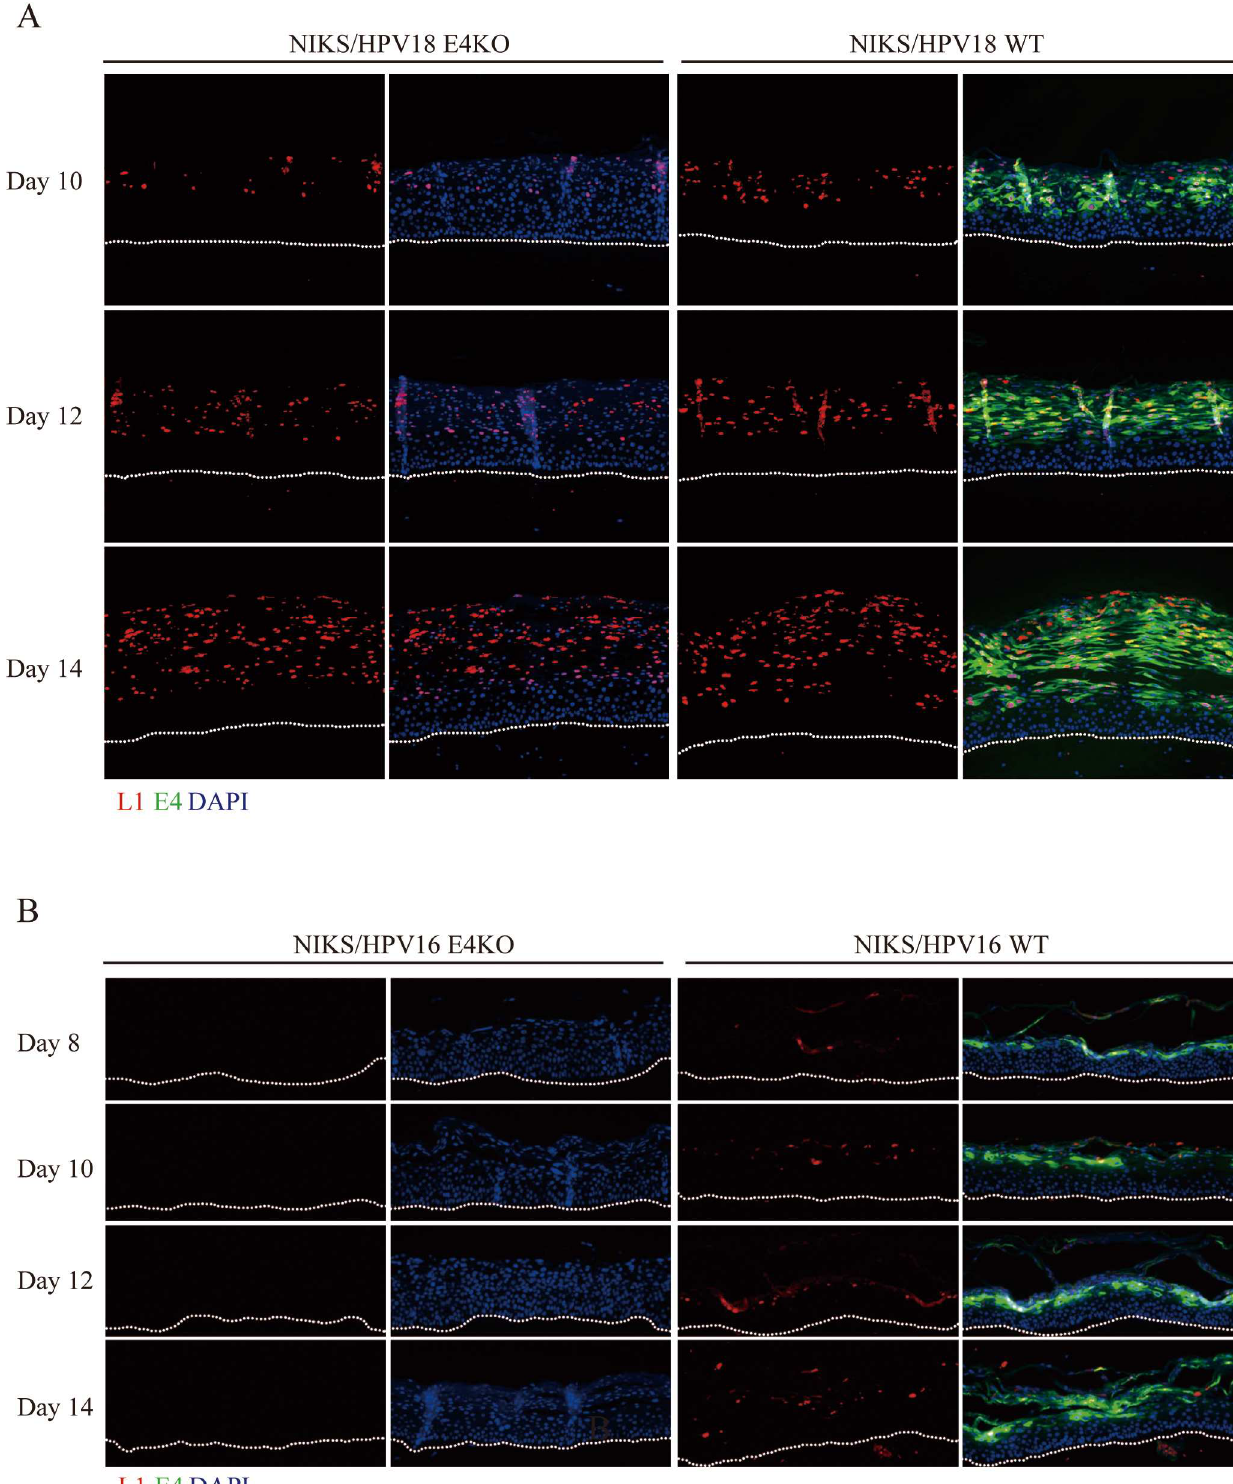
Fig 3. Viral capsid protein expression appears linked to viral genome amplification success in HPV16 and 18 rafts. Raft sections derived from NIKS cells harboringHPV18 (A) or HPV16 (B) WT or E4KO genomeswere analyzedat different time points post-infection, before being stained for E1^E4 (green), L1 (red) and DNA (blue; DAPI). The dotted lines indicatethe position of the basal layer. Images were captured using a 10x objective.